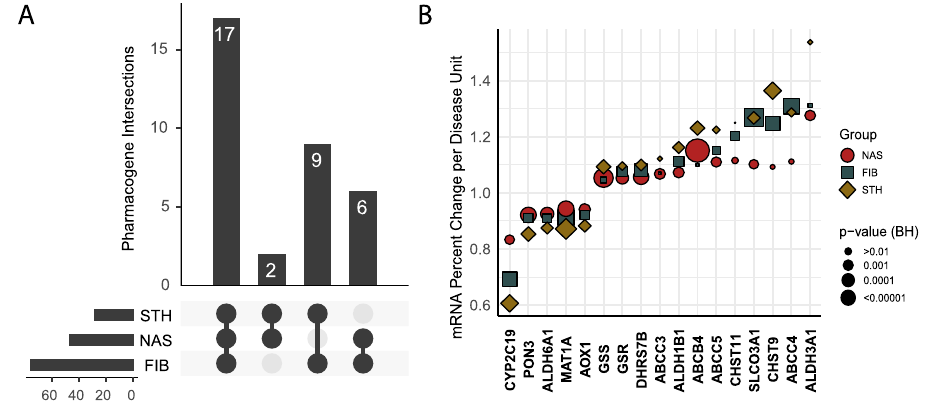
Fig. 5 | Comparison of the Benjamini-Hochberg signi fi cant pharmacogene expression changes between disease subgroups. A Upset plot showing the commonalityinsigni fi cantlychangedpharmacogenesbetweendiseasesubgroups. B Scatter plot showing mRNA percent change per unit of disease for the 17 phar- macogenesincommonbetweenalldiseasesubgroups.Forexample,theplotshows that with each 1 unit increase in fi brosis stage, CYP2C19 transcript abundance